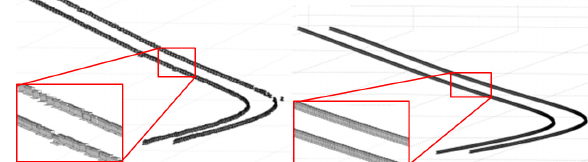
Figure 8. Individual rail pieces before (left) and after (right) Fourier curve fitting for area 1.